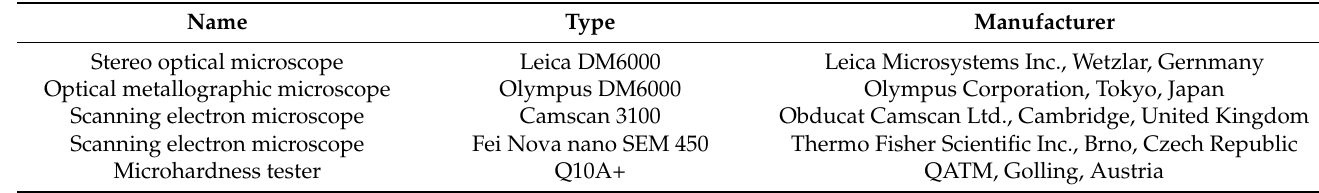
Table 3. Main experimental instruments used in this paper.